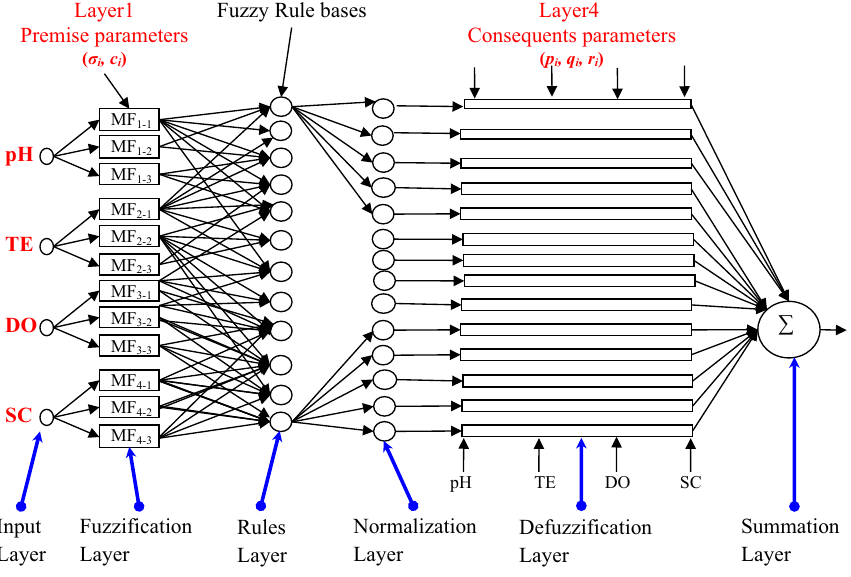
Fig. 2 Architecture of ANFIS with four input variables used for modeling PC